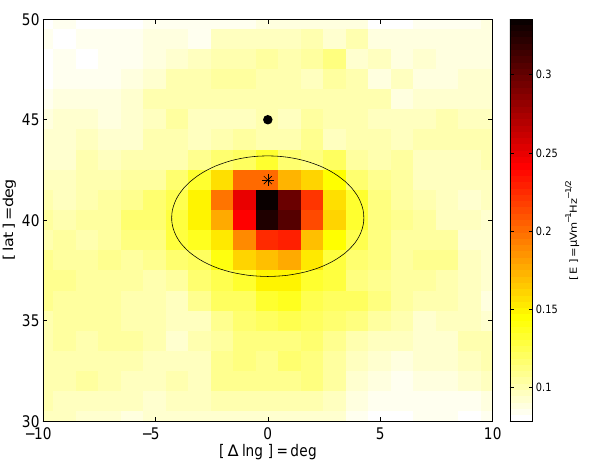
Fig. 2. The average LORAN transmitter (solid dot) illuminates a circular area (red/black blob) of the plasmasphere at ∼ 660km height. The luminosity patch has a radius of ∼ 300km (ellipse), a power density of ∼ 22µW/Hz, and it exhibits a southward dis- placement of ∼ 450km with respect to the location of the LORAN transmitter. The apparent location of the LORAN transmitter at ∼ 660km height is located ∼ 300km southward (star) when an up- ward propagation of the radio waves along the geomagnetic field line is assumed. The remaining residual southward displacement of ∼ 150km suggests that the radio waves undergo sub-ionospheric propagation prior to entering a magnetospheric duct and escaping into near-Earth space.